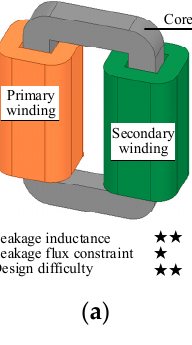
Figure 2. Comparison of different integration structures. ( a ) SW LII, ( b ) CW LII, ( c ) SW ELII, ( d ) CW ELII.